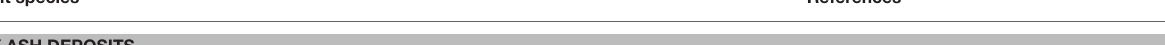
TABLE 2 | Plant species grown on fly ash deposits and mine waste worldwide. Plant